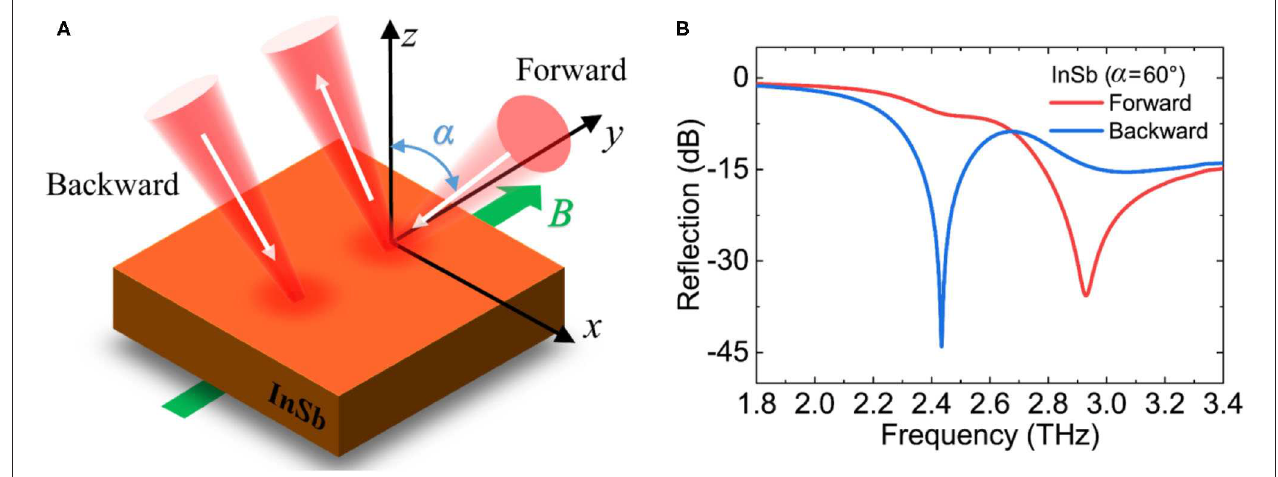
FIGURE 1 | (A) Schematic diagram of the THz optical isolator for the InSb wafer with magnetic field along the y axis. A THz beam is incident in the x – z plane with the incident angle of α and is p -polarized. (B) The reflection spectrum of the forward wave and backward wave when α